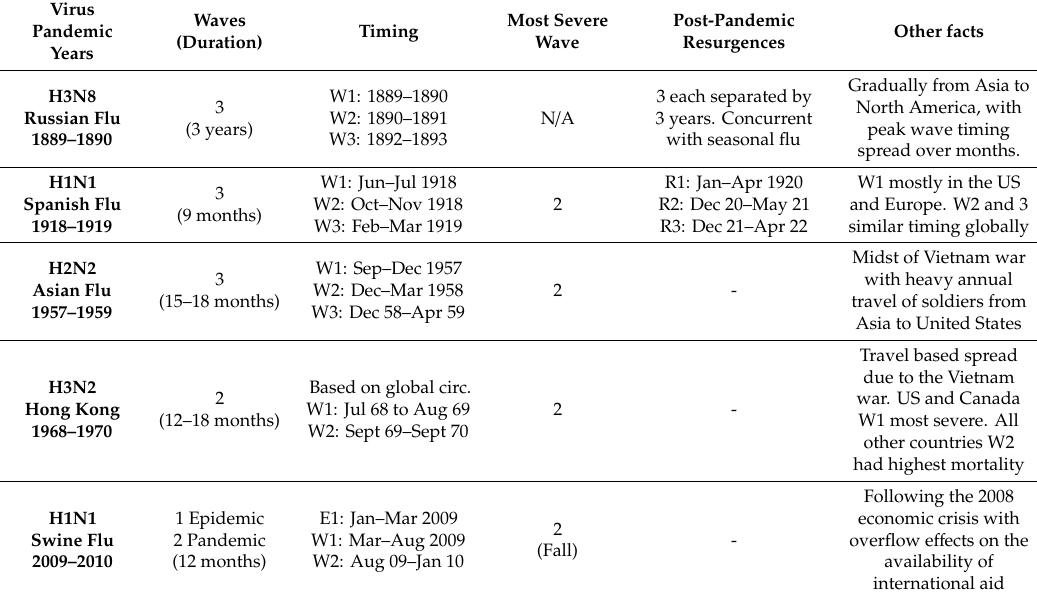
Table 1. Comparison of influenza pandemics from late 19th to 21st